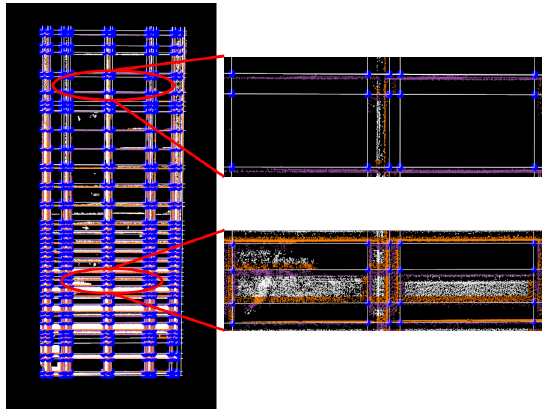
Figure 4. Recovery of openings within low point density (upper right) and noise areas (low right). The height and width of the fac¸ade point cloud (left) from mobile LiDAR are 52 . 52 m and 21 . 61 m